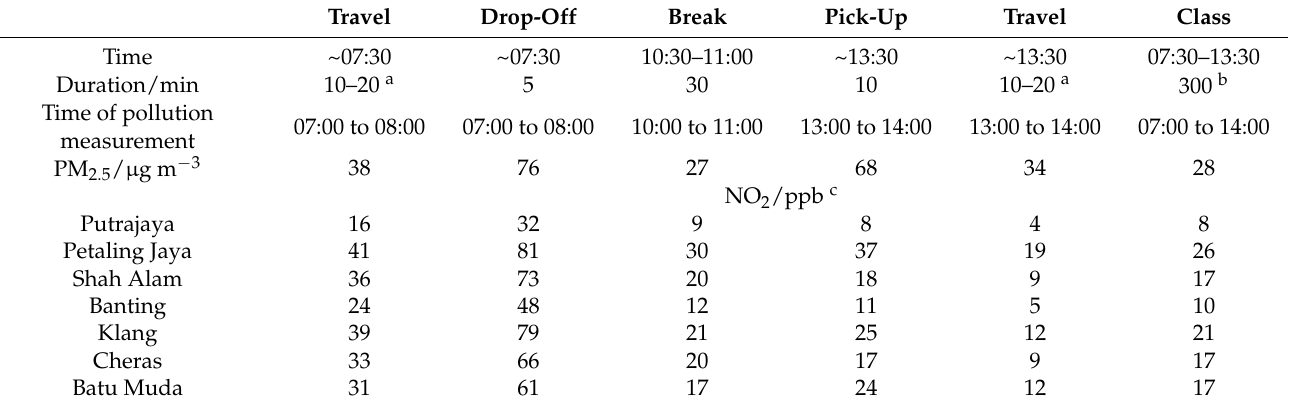
Table 1. Pollutant concentrations (from hourly averages from 2019 data) adopted for various activ- ities related to school at sites around Kuala Lumpur.